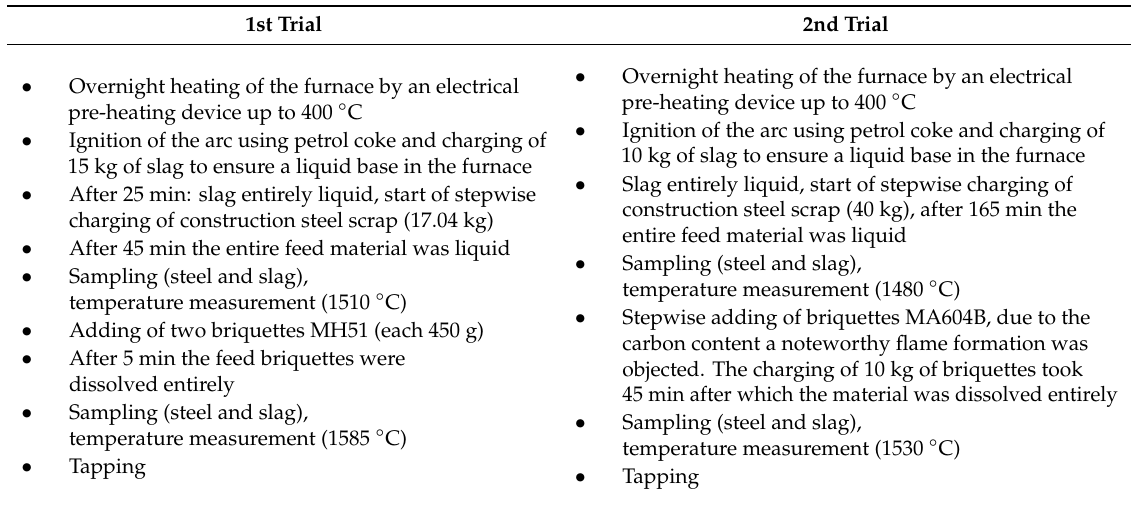
Table 3. Trial test procedures.